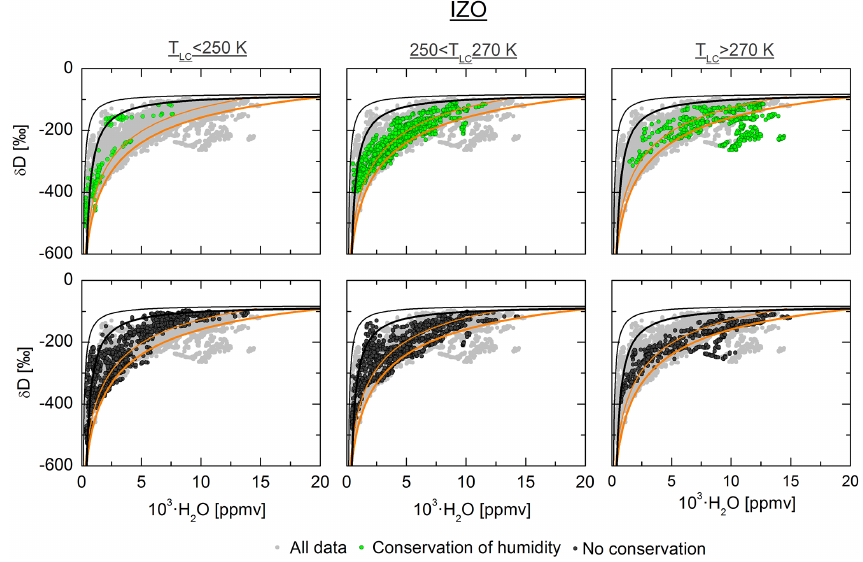
Figure 8. H 2 O- δ D distribution (10min data within ± 3h of the arrival time of the air mass) measured at IZO station and analysed with regard to the LC point. The data set has been grouped in three groups corresponding to different condensation temperatures: T LC < 250K, 250K <T LC < 270K and T LC > 270K. The H 2 O- δ D pairs measured for reduced mixing since LC ( (cid:49) H 2 O ± 0.1) are presented in green. Pairs measured for increased mixing since LC ( (cid:49) H 2 O outside ± 0.1) are presented in dark grey. Rayleigh and mixing curves are plotted as in Figs. 5 and 6.